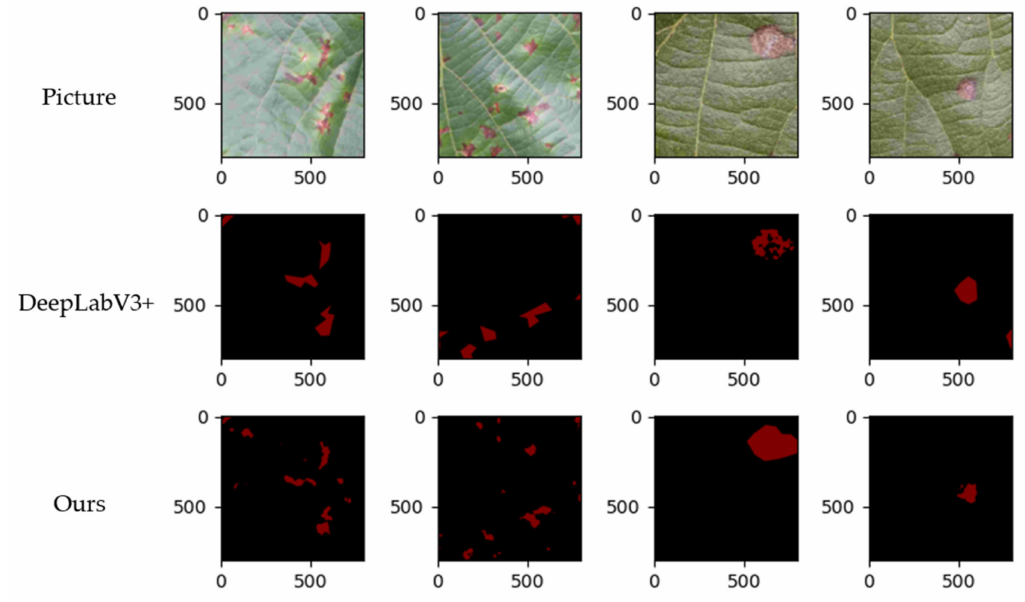
Figure 10. Comparison of performance.